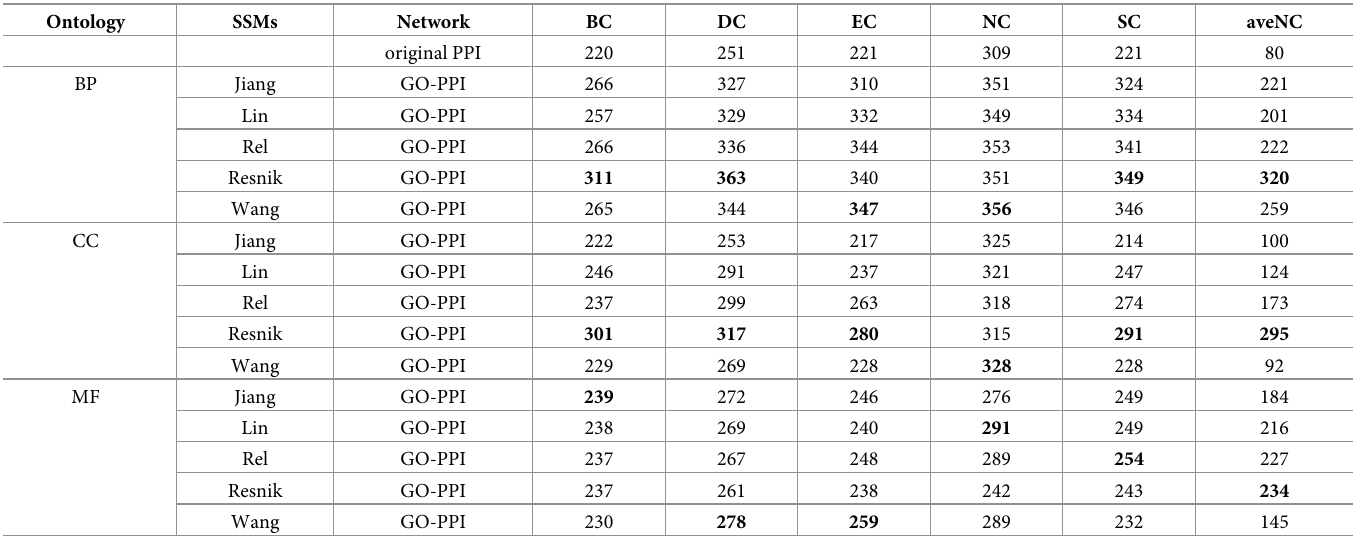
However, for the MF and CC subontologies, some of the centrality methods perform poorly under the refined GO-PPI network, such as the BC method under the Jiang-CC (the Jiang method under the CC subontology) PPI network and the DC method under the Resnik-MF (the Resnik method under the MF subontology) PPI network. The maximum number of essential proteins predicted by the NC method in all five newly constructed PPI networks under the MF subontology is 306, which is compared to the 318 correctly predicted essential proteins under the original PPI network. Considering the number of interactions under the refined GO-PPI network in the MF subontology (Table 2), this is might due to the GO annota- tion under MF is incomplete for the protein pairs in the new DIP dataset; therefore, the